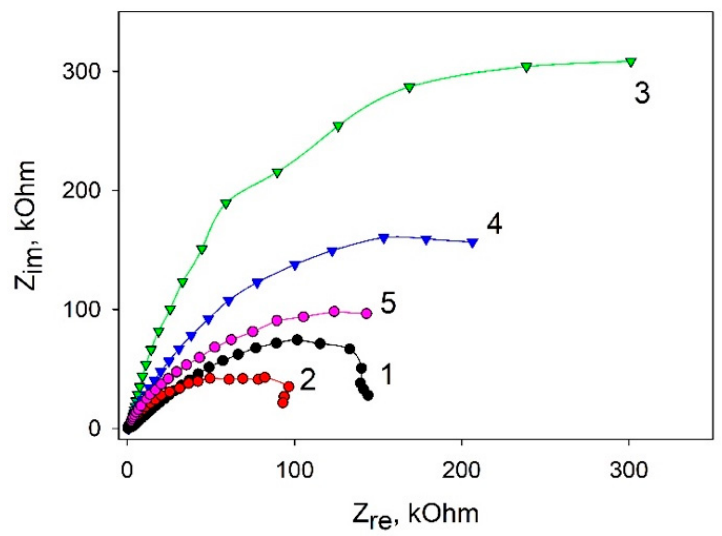
Figure 4. Nyquist diagrams for various composites: 1, SPE/PEDOT:PSS; 2, SPE/PEDOT: PSS/graphene; 3, SPE/PEDOT:PSS/graphene/Nafion; 4, SPE/PEDOT:PSS/graphene/Nafion/ G. oxydans ; 5, SPE/PEDOT/graphene/Nafion/ G. oxydans at an addition of 1 mM glucose. Measurements were carried out in the presence of 5 mM [Fe(CN) 6 ] 3-/4- . Thus, using two electrochemical methods, we showed that cells were reliably immobi- lized on the electrode surface and that addition of glucose led to electron transfer and an increase of currents in the system.